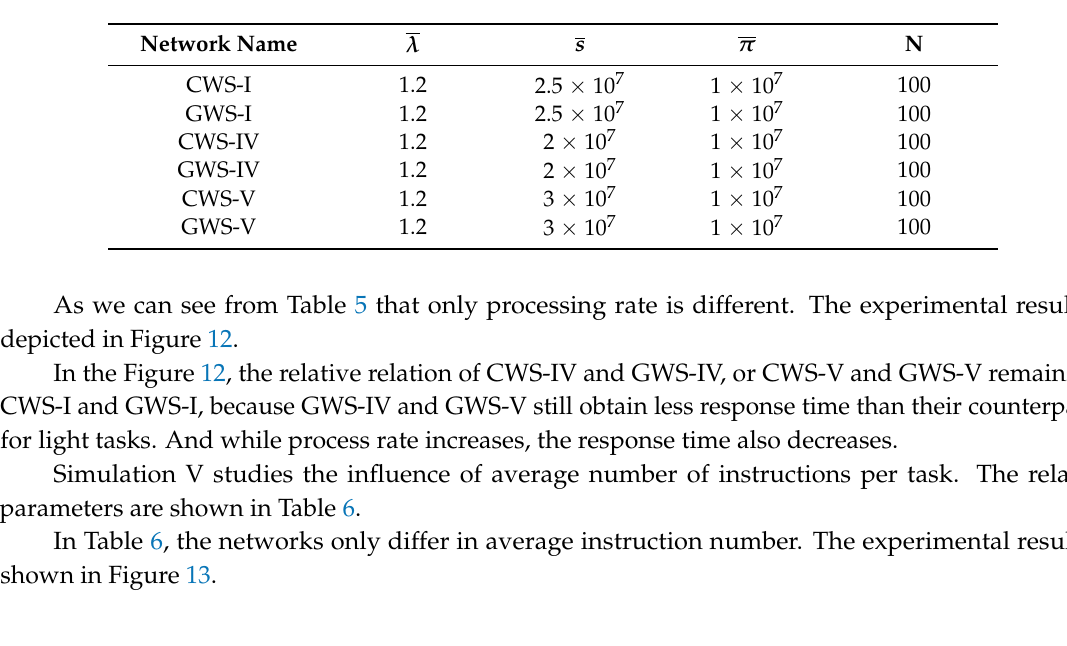
Table 5. Parameters of Simulation IV.